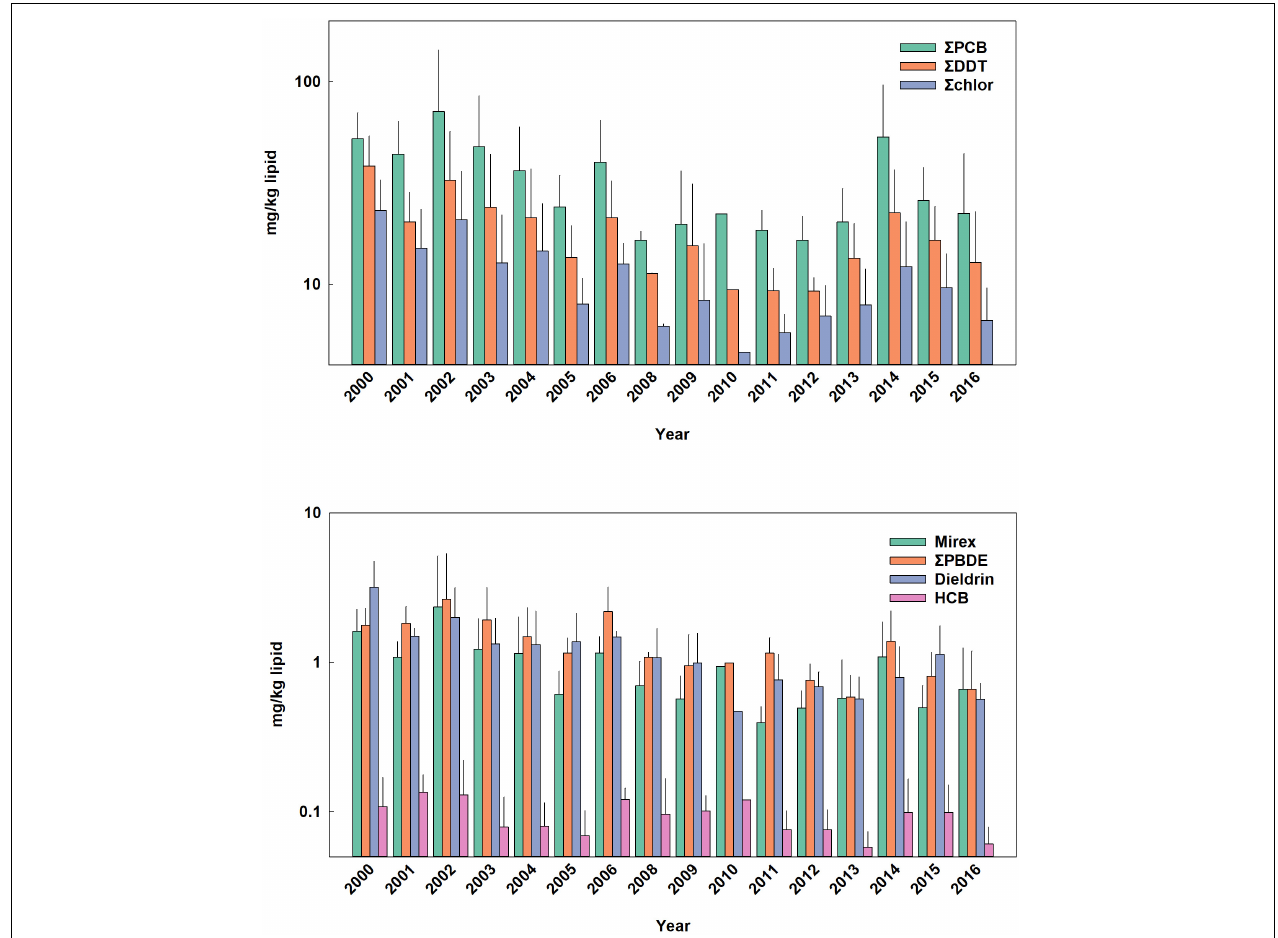
FIGURE 3 | Temporal trends of POPs in calf (combination of nursing and foraging) bottlenose dolphins. Bars are mean ± standard deviation. Values in parentheses are for error bars that are off scale.